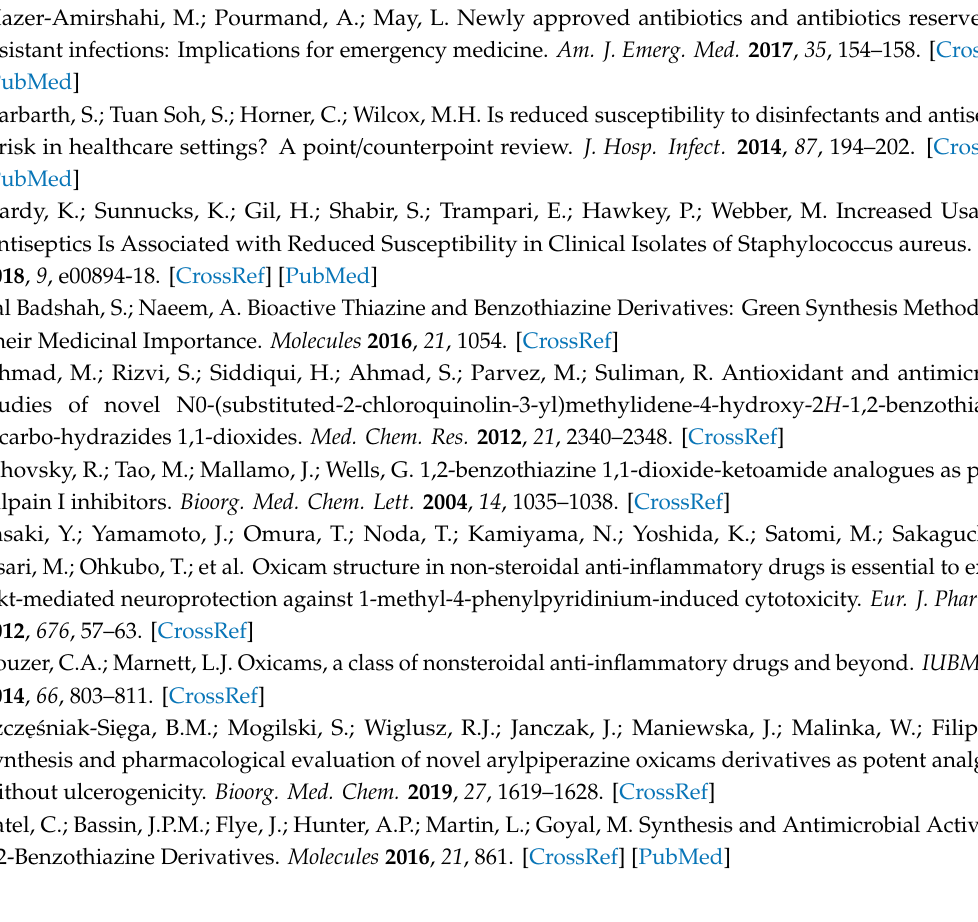
Supplementary Materials: Table S1. DFT optimized parameters of 7i. Spectroscopic data for compounds 7j , 7k and 7l . Table S2. Inhibition zones [mm] of S. aureus growth being result of tested compounds’ activity. Table S3. Inhibition zones [mm] of E. faecalis growth being result of tested compounds’ activity. Table S4. MIC and MBC values (mg / mL) for Gram-positive microorganisms. “X”—no bactericidal activity (MBC) in tested concentration of compound applied. Table S5. MIC and MBC values for Gram-negative microorganisms. “X”—no bactericidal activity (MBC) in tested concentration of compound applied. Table S6. Crystal data and details of the structure determination for compound 7i . Table S7. The highest tested concentration 1,2-benzothiazine 1,1-dioxide derivatives. Table S8. The absorbance values of samples and control. Table S9. Concentrations of DMSO [%] used for 1,2-benzothiazine 1,1-dioxide derivatives dissolution to perform cytotoxicity assay. Table S10. Cytotoxicity of applied concentrations of DMSO. The cytotoxicity was calculated as % (%C tx ) using the formula: %C tx = 100% − (A b / A k ) × 100%. Figure S1. Inhibition of bacterial growth in the area of precipitation